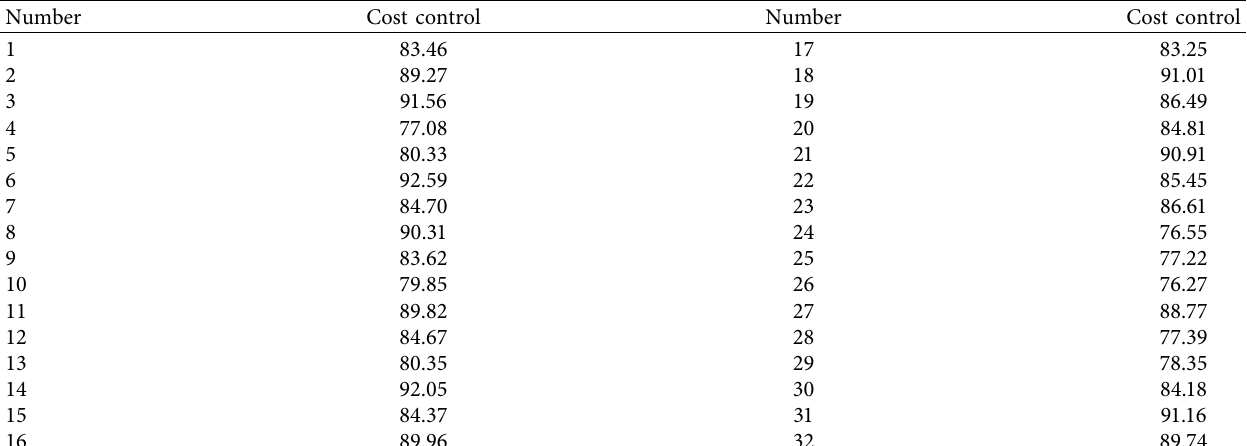
Table 2: Evaluation of cost control performance.